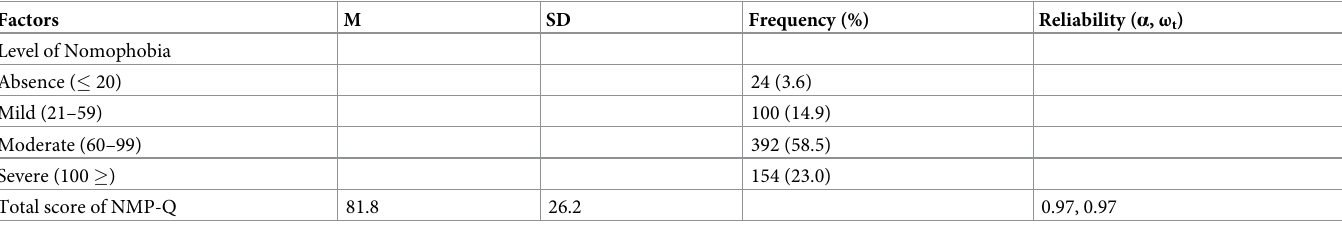
Table 3. Descriptive statistics of the levels of